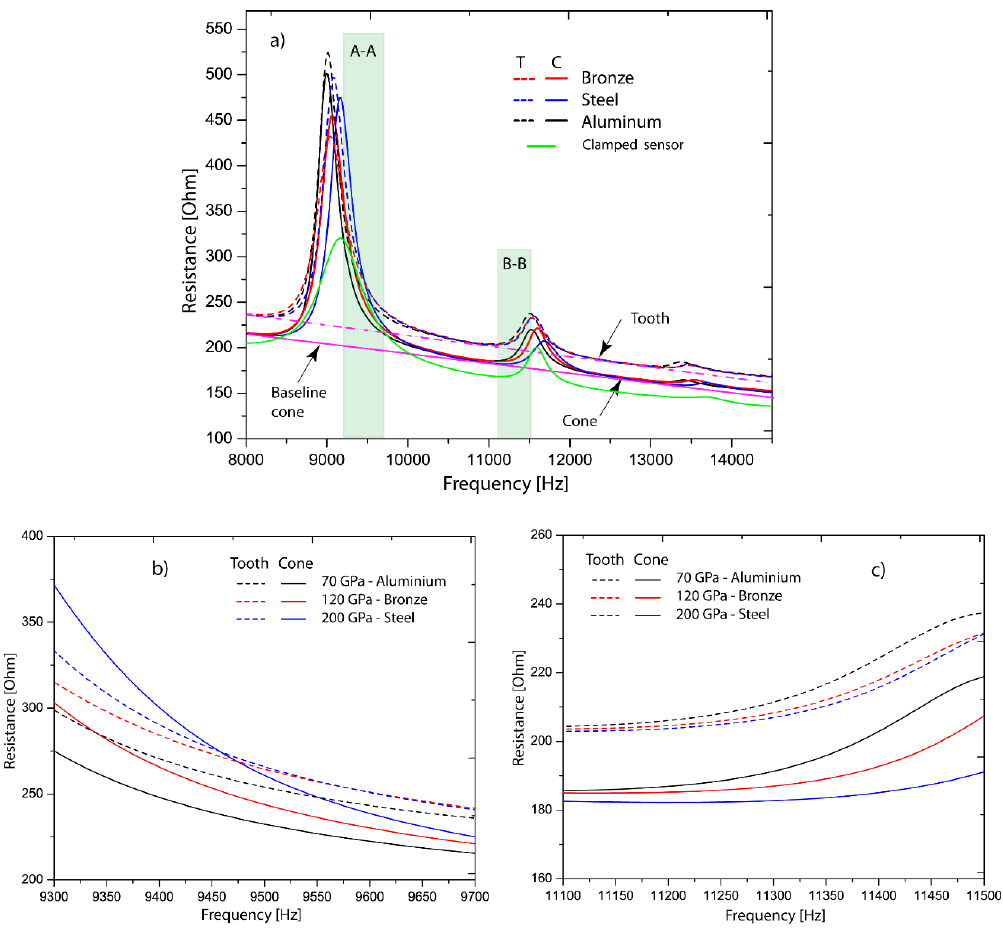
Figure 7. ( a ) Electrical resistance for experiments 1 and 2 in the frequency spectrum 8 kHz–15 kHz. ( b ) Electrical resistance signals in the first monitoring window (9.3–9.7 kHz). ( c ) Electrical